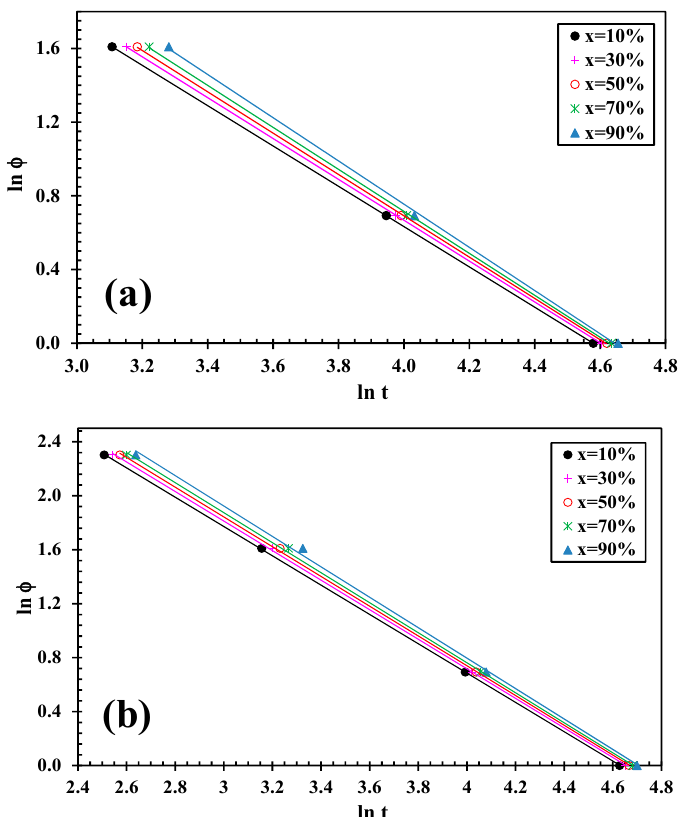
Figure 7. Lui plots for melt crystallization of ( a ) PLLA and ( b ) PLLA / 2D-WS 2 (0.5 wt %). The f ( T ) values increased rapidly with an increase in the relative crystallinity of all samples.